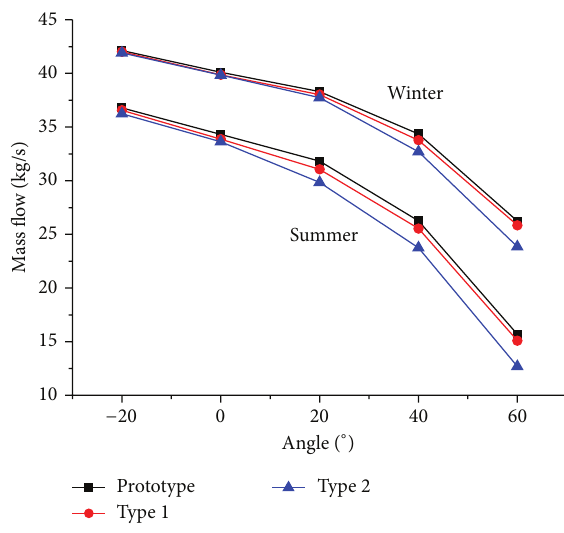
Figure 6: The change of mass flow with the setting angles.